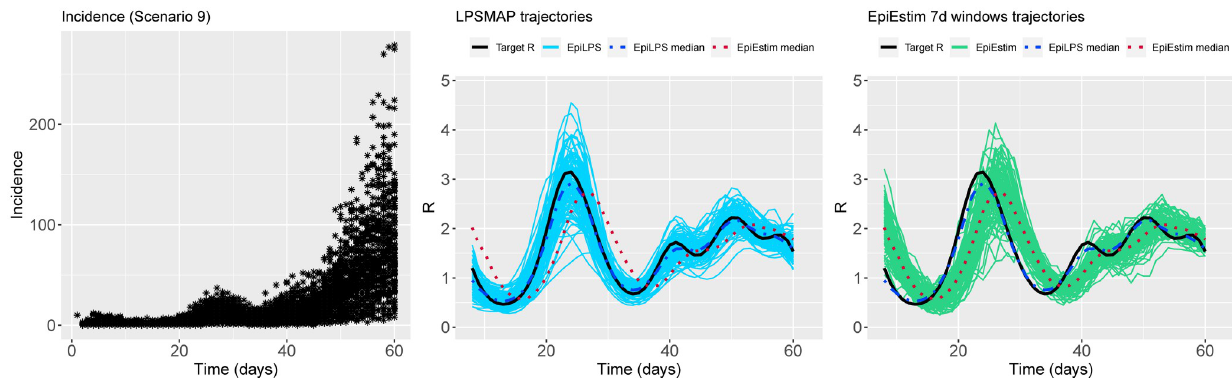
Fig 4. (Left) Simulated incidence data for Scenario 9. (Center) Estimated trajectories of R trajectories of R with EpiEstim using weekly sliding windows and R t (dashed) and EpiEstim (dotted) is also shown.